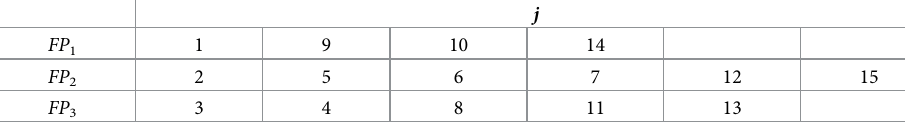
Table 5. The fictive packets regrouping the originally